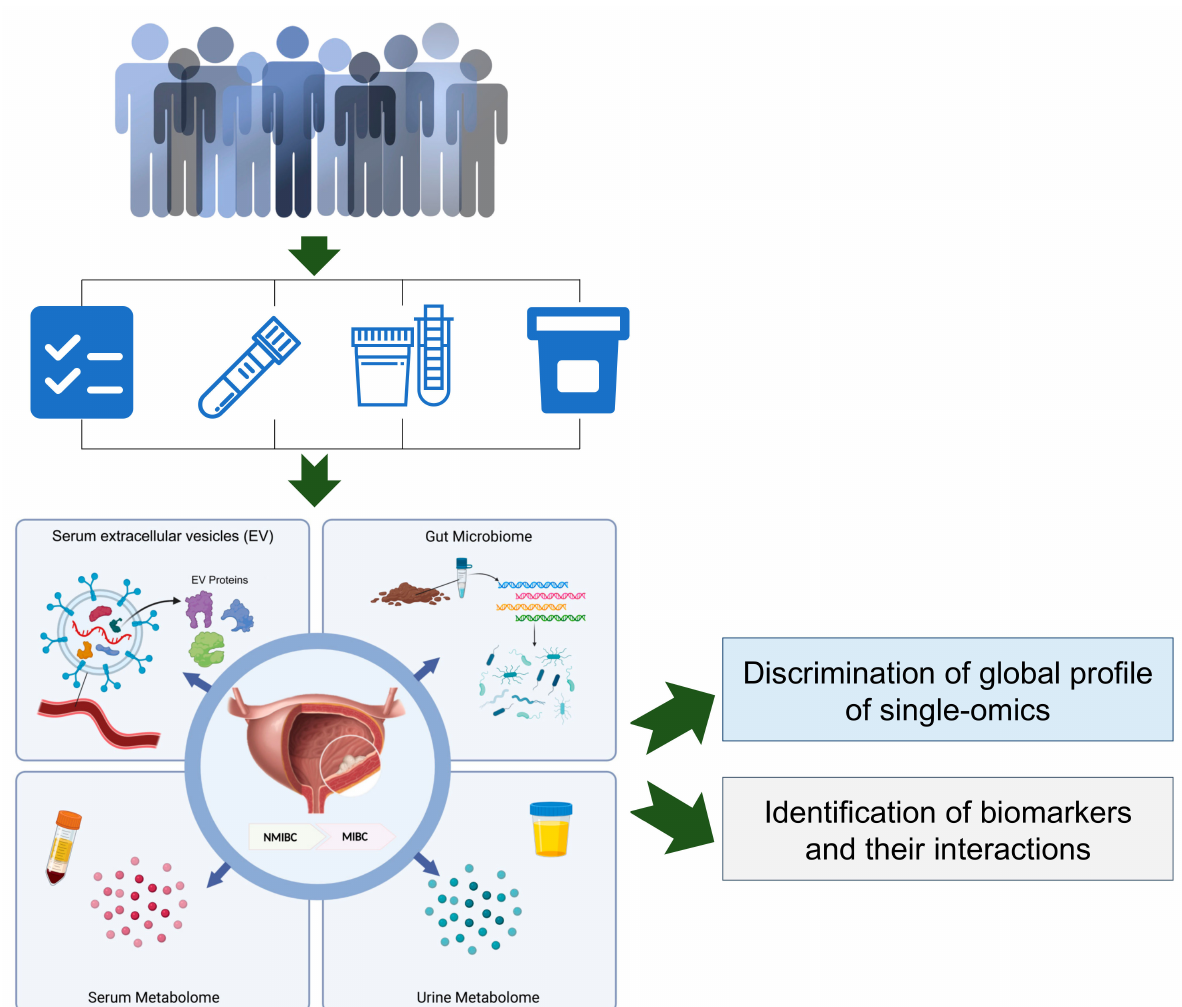
Figure 1. Design and work-flow of the current study. The NMIBC and MIBC patients were recruited with specimen collection for blood, urine and stool. Abbreviations: NMIBC, non-muscle-invasive bladder cancer; MIBC, muscle-invasive bladder